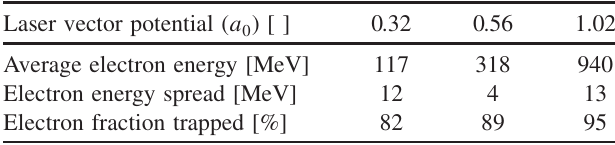
TABLE VI. Parameters of accelerated electron bunches in the various laser regimes when injecting 300 fs in front of the laser